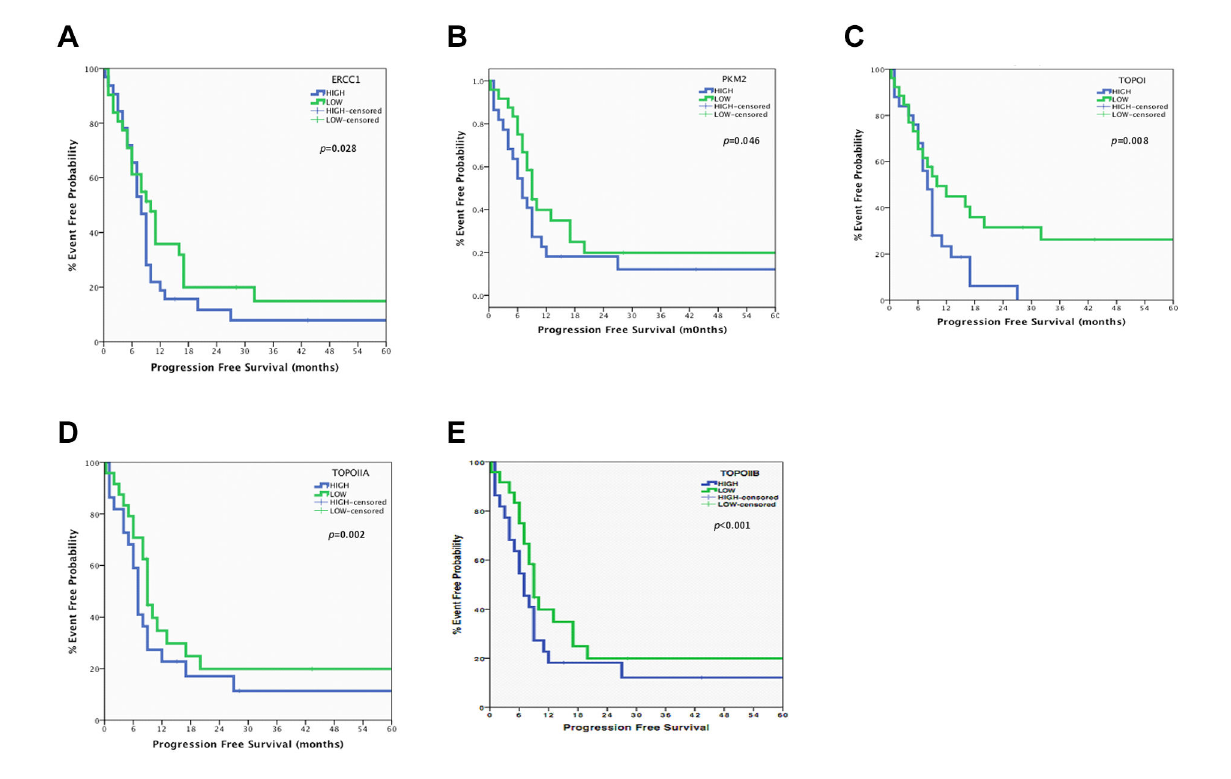
Figure 1. Progression Free Survival in Limited Stage-SCLC. A. ERCC1 mRNA levels and Progression Free Survival in Limited Stage-SCLC. B. PKM2 mRNA levels and Progression Free Survival in Limited Stage-SCLC. C. TOPOI mRNA levels and Progression Free Survival in Limited Stage-SCLC. D. TOPOIIA mRNA levels and Progression Free Survival in Limited Stage-SCLC. E. TOPOIIB mRNA levels and Progression Free Survival in Limited Stage-SCLC. doi: